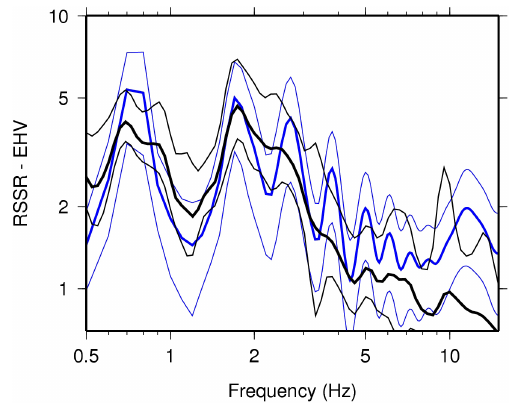
Figure 6. Comparison between the RSSR (blue lines) and EHV (black lines) methods at the Casaglia site. The RSSR is obtained di- viding the surface earthquake records by the bottom borehole sensor after the path correct